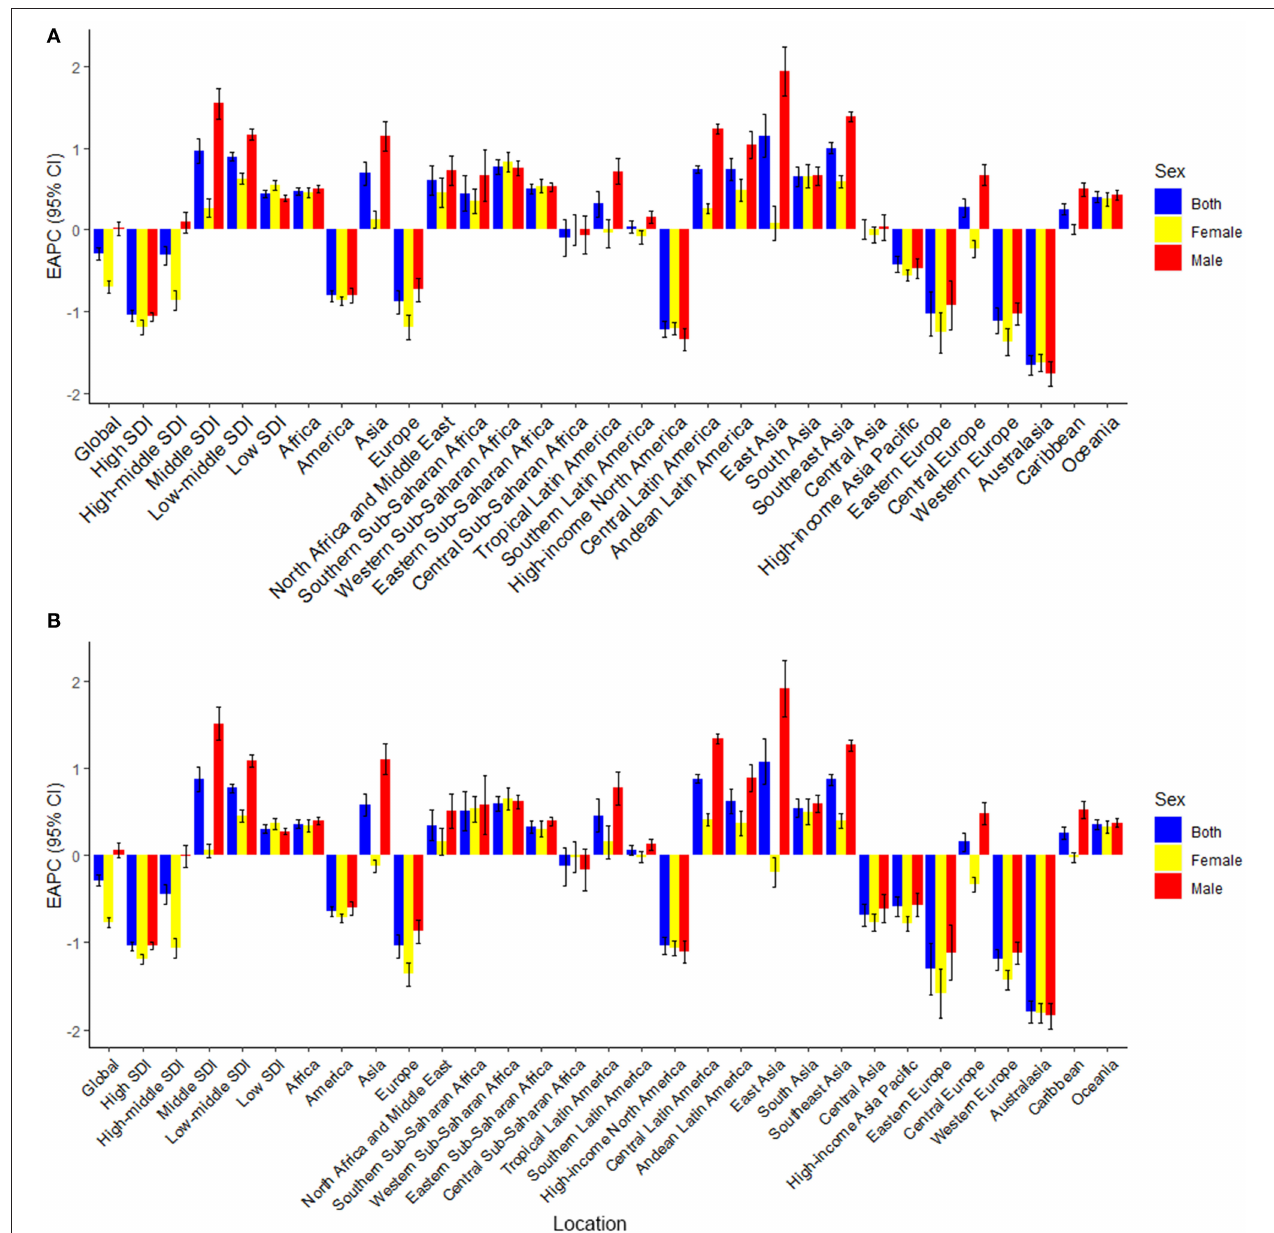
FIGURE 5 | The estimated annual percentage changes (EAPCs) of age-standardized death and DALY rate for dietary risk related colorectal cancer. (A) EAPCs of ASDR (per 100,000 population); (B) EAPCs of age-standardized DALY rate (per 100,000 population). EAPC, estimated annual percentage changes; DALY, disability-adjusted